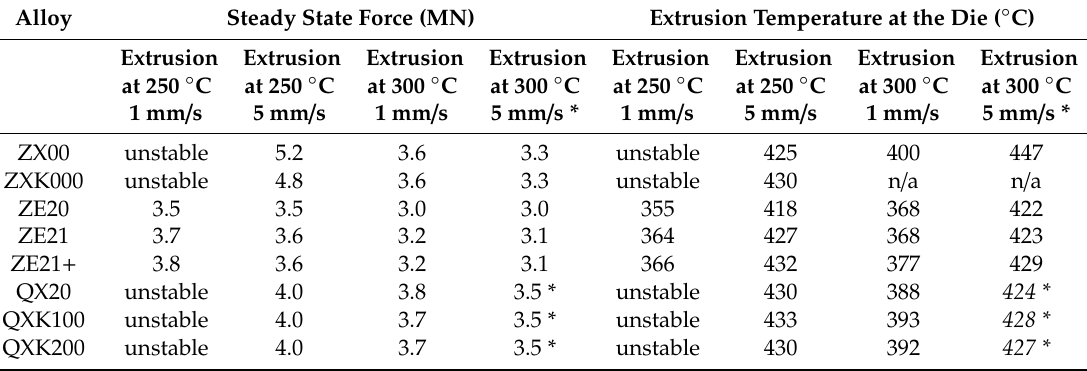
Table 2. Steady state forces and steady state extrusion temperatures for the alloys of this study during extrusion with varied temperatures and extrusion speeds; accuracy for the force ± 0.2 MN; accuracy for the temperature measurement ± 2 ◦ C; n / a: these data were not accessible during the measurements; unstable: no steady state flow